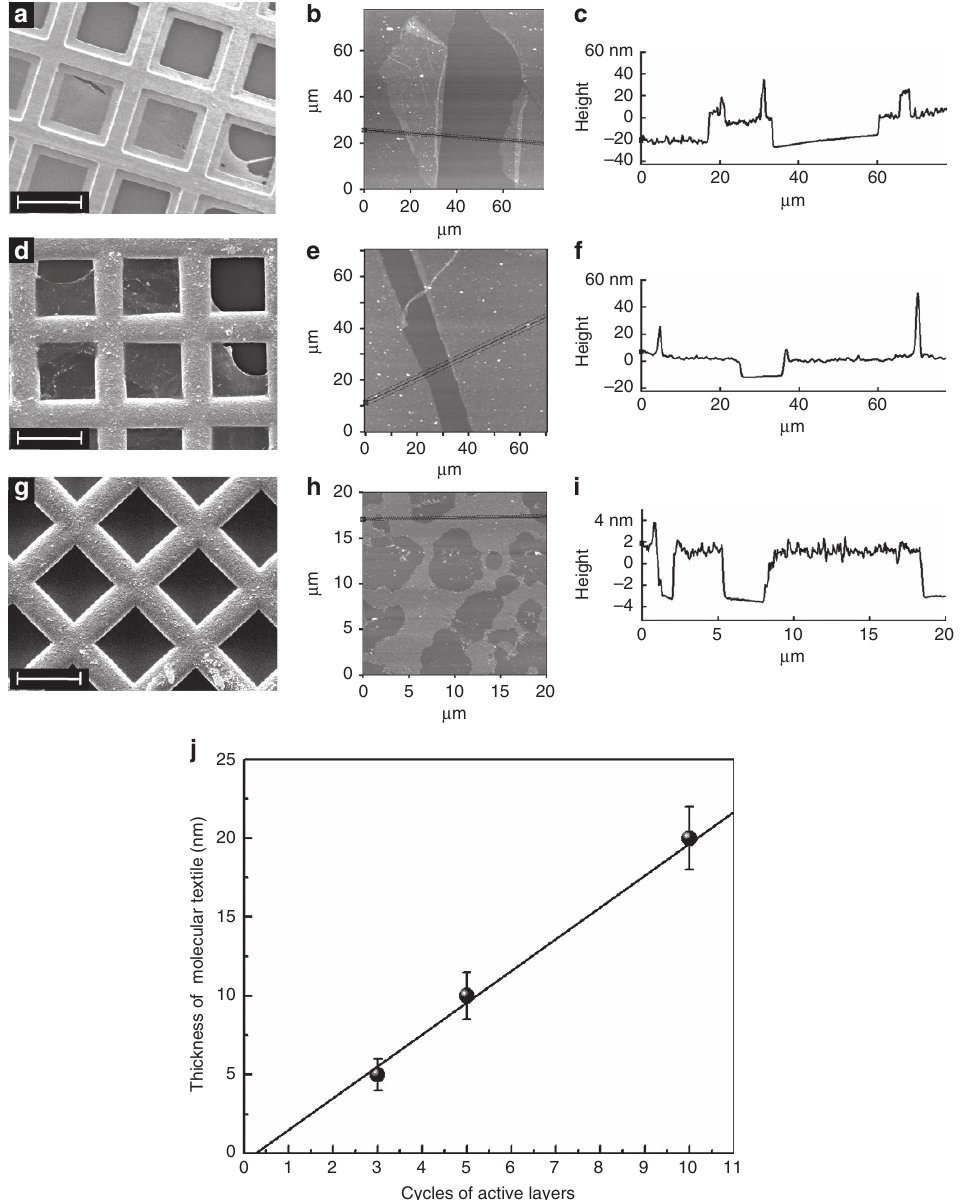
Figure 4 | Imaging of molecular textiles. ( a ) SEM image of 10 cycles of molecular weaving attached on TEM grids. ( b ) AFM image and ( c ) height profile of 10 cycles of molecular weaving attached on a smooth Si substrate. ( d ) SEM image of 5 cycles of molecular weaving attached on TEM grids. ( e ) AFM image and ( f ) height profile of 5 cycles of molecular weaving attached on a smooth Si substrate. ( g ) SEM image of 3 cycles of molecule weaving attached on TEM grids. ( h ) AFM image and ( i ) height profile of 3 cycles of molecular weaving attached on a smooth Si substrate. ( j ) Dependence of the textiles thickness, as measured by AFM, on the number of cycles to form ABAB-SURMOFs active layers. The length of the white scale bar in the SEM images is 50 m